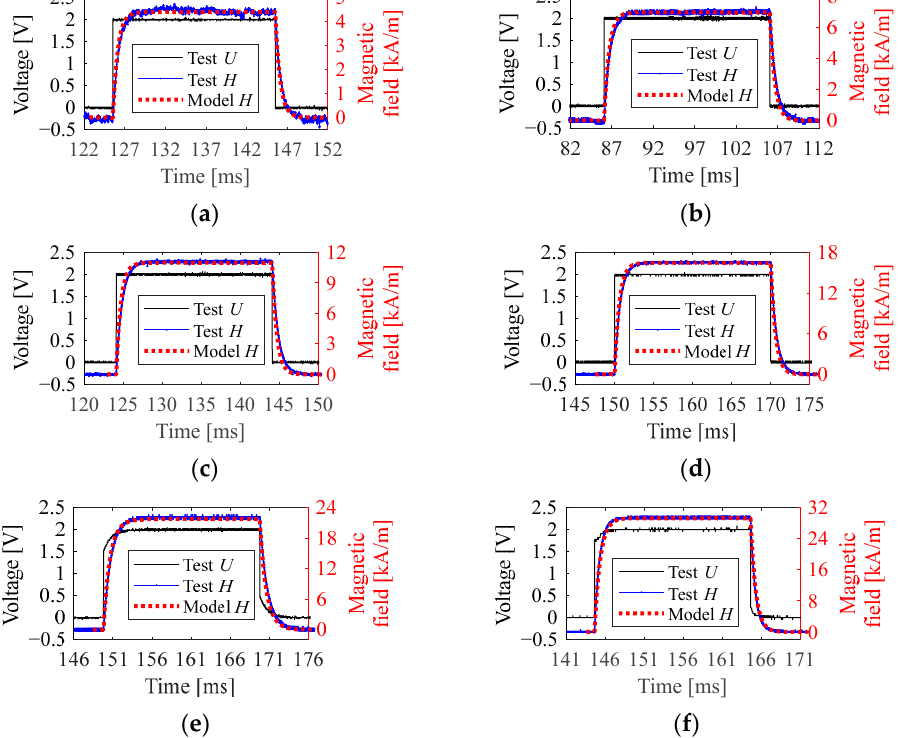
precisely calculated the amplitudes and effectively described the curve shapes under different wire diameters as the transient-state results were also quite close.